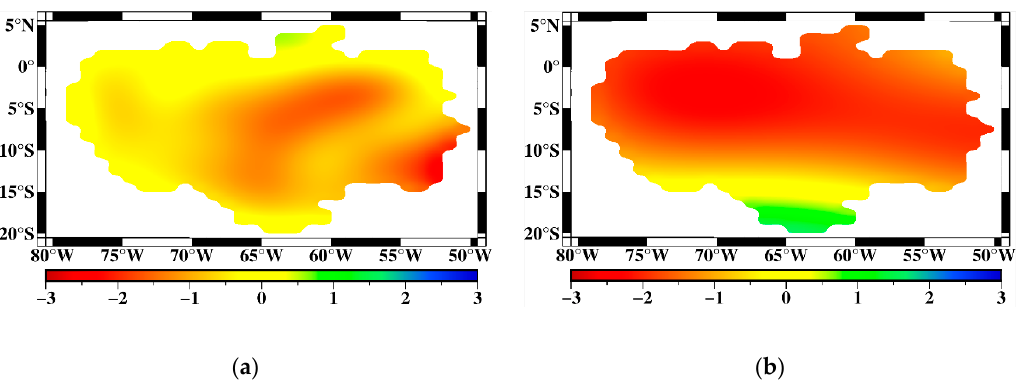
Figure 9. Long-term trends of TWSC in the Amazon River basin calculated by GRACE and Swarm. ( a ) GRACE results; ( b ) Swarm results.